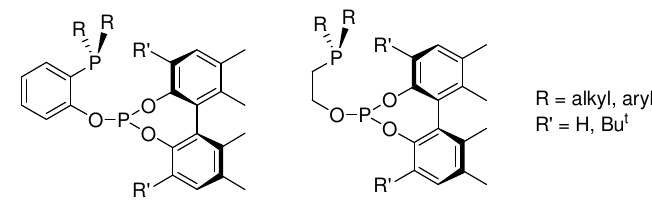
Figure 2. General structure of P-OP